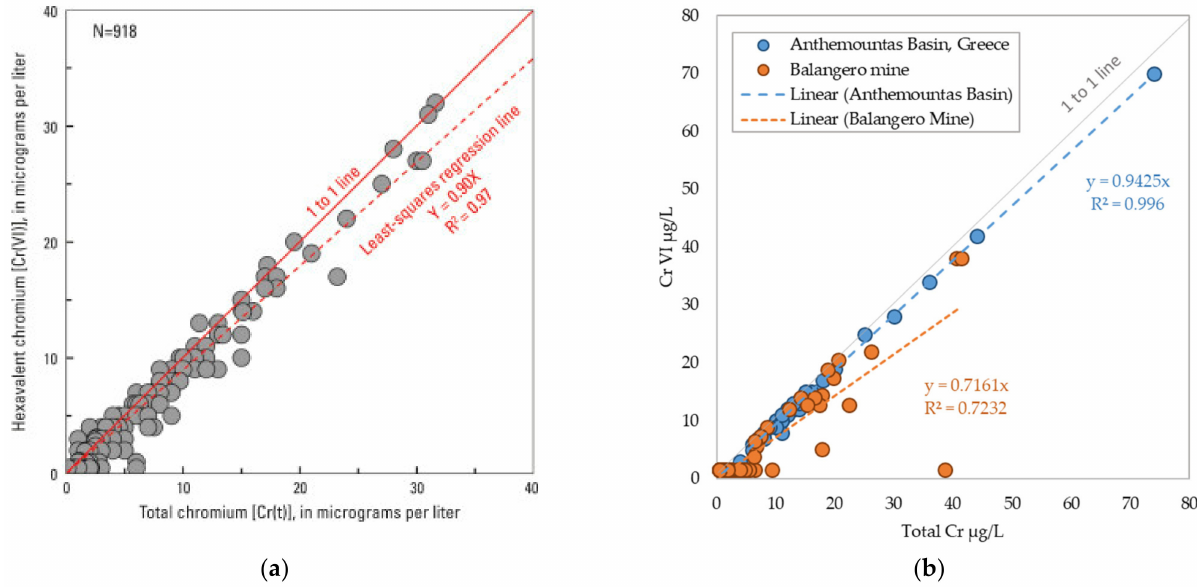
Figure 4. Relationship between Cr and Cr VI: ( a ) in drinking waters from California [52]; ( b ) in waters from the An- themountas Basin, Greece [9] and at our study site (regression calculated using the total number of PTE measurements, including